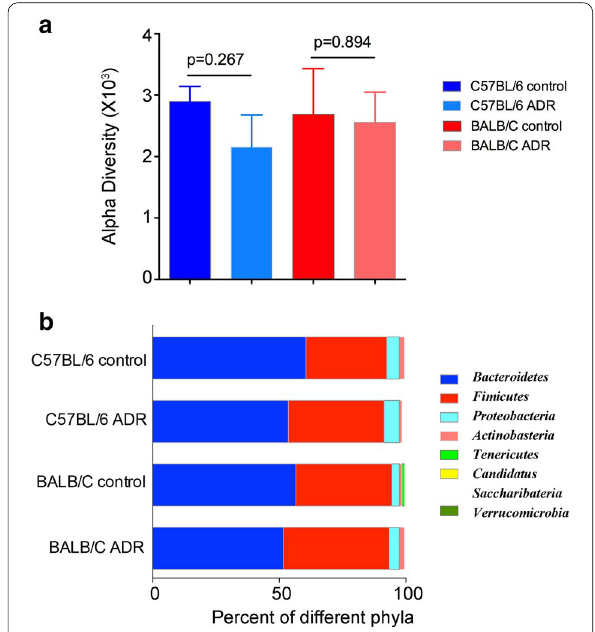
Fig. 2 Gut microbiome altered with ADR at phylum level. a The alpha diversity in the control and ADR group of different mice. b The gut microbiome composition profiles at the phylum